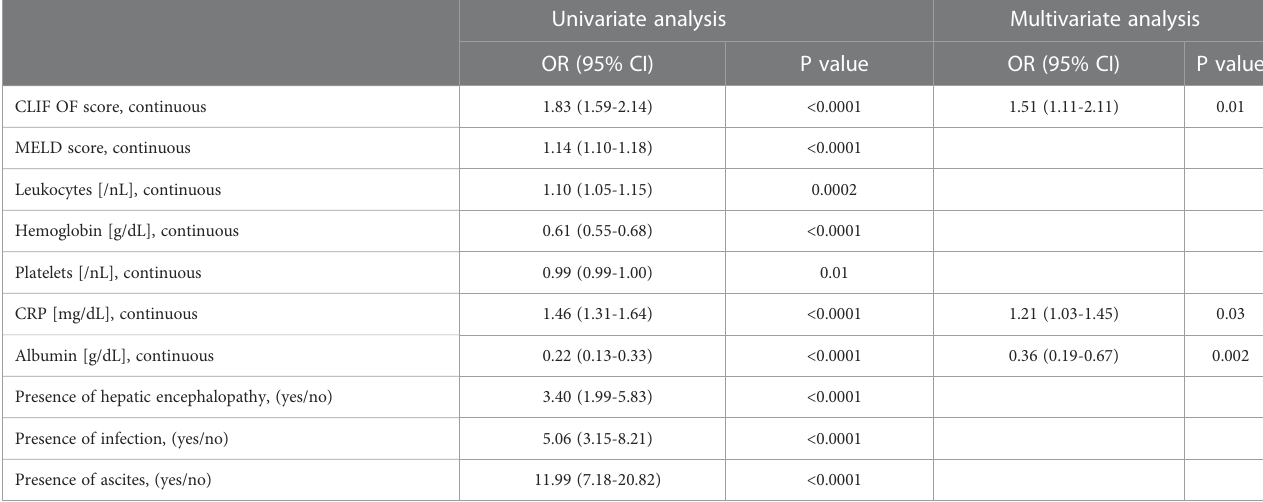
TABLE 3 Regression analysis of factors associated with non-thyroidal illness syndrome (NTIS).